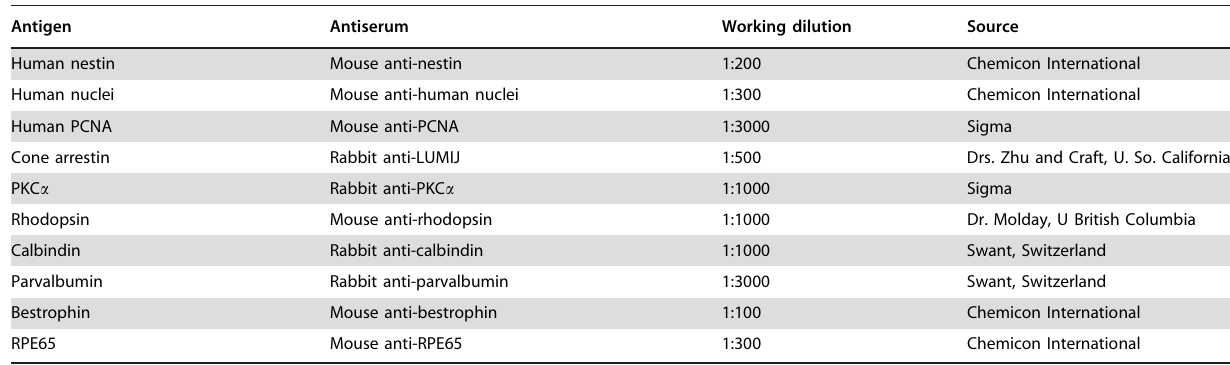
Table 1. Sources and Working Dilutions of Antibodies for Immunohistochemistry. .. ... .... ... ... .... ... ... .... ... ... .... ... ... .... ... ... .... ... ... .... ... ... .... ... ... .... ... ... .... ... ... .... ... ... .... ... ... .... ... ... .... ... ... .